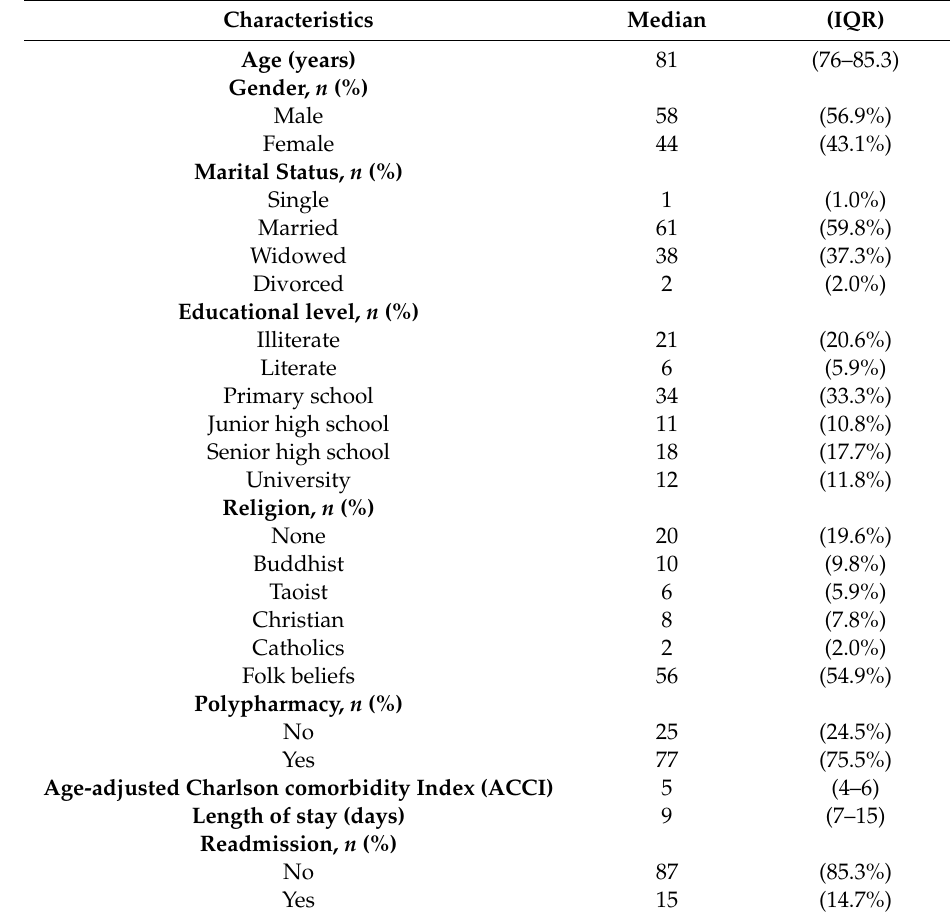
Table 1. Characteristics of the patients ( n =